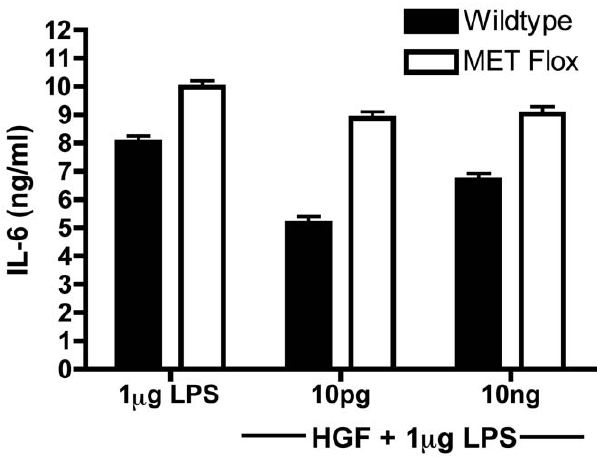
Figure 1. HGF modulates IL-6 production in LPS stimulated macrophages. BMM derived from C57BL6 mice were pretreated with or without 10 pg and 10 ng HGF for 24 hours and stimulated with 1 m g/ml LPS. Cell culture media was collected (24 h) and IL-6 levels were measured by ELISA. Results are representative of the mean ( 6 SEM) of three independent experiment done in triplicate, * indicates , 0.001.